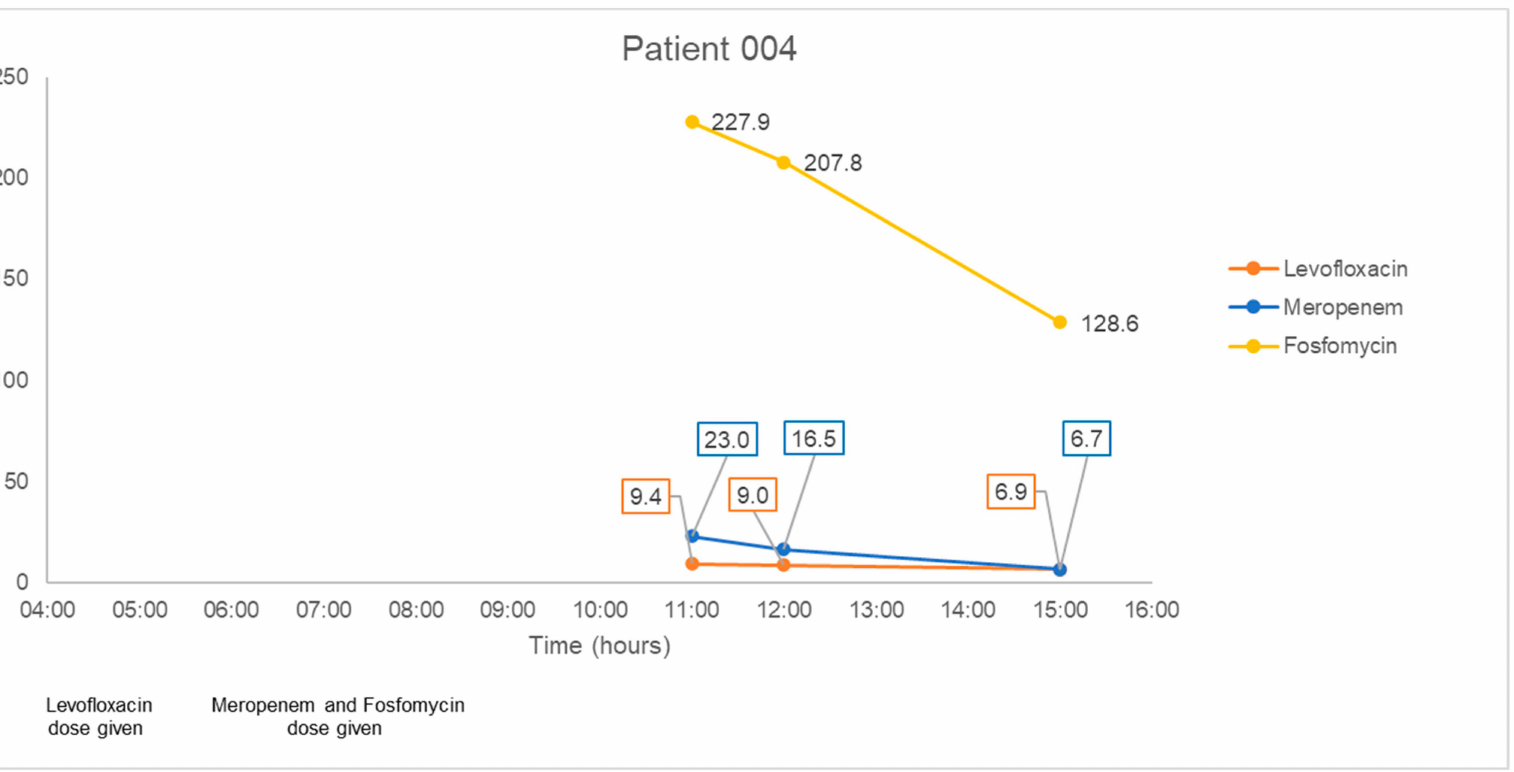
Figure 1. ( A – D ). Plasma concentration-time courses of fosfomycin and the respective combination antibiotics in the four patients. Black arrows depict antibiotic administration. Dialysis treatment duration is depicted by box size. IHD, intermittent